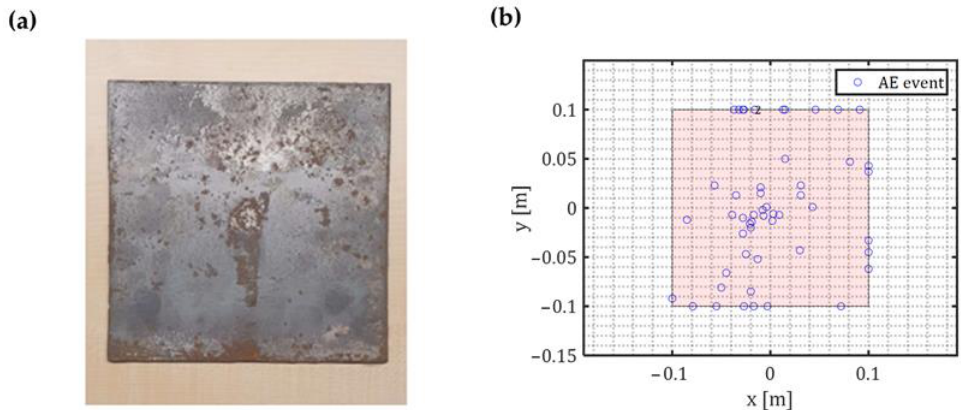
Figure 12. ( a ) Corrosion damage on the baseplate; ( b ) Localisation results on the